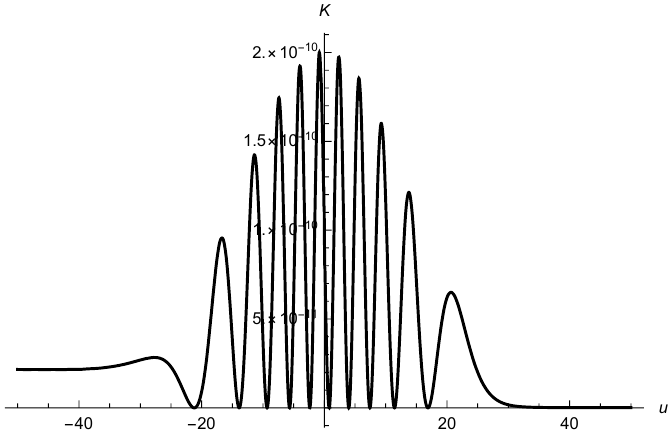
Figure 6. K ( u ) , considering H 1 , the initial conditions III and λ = 13.6043.